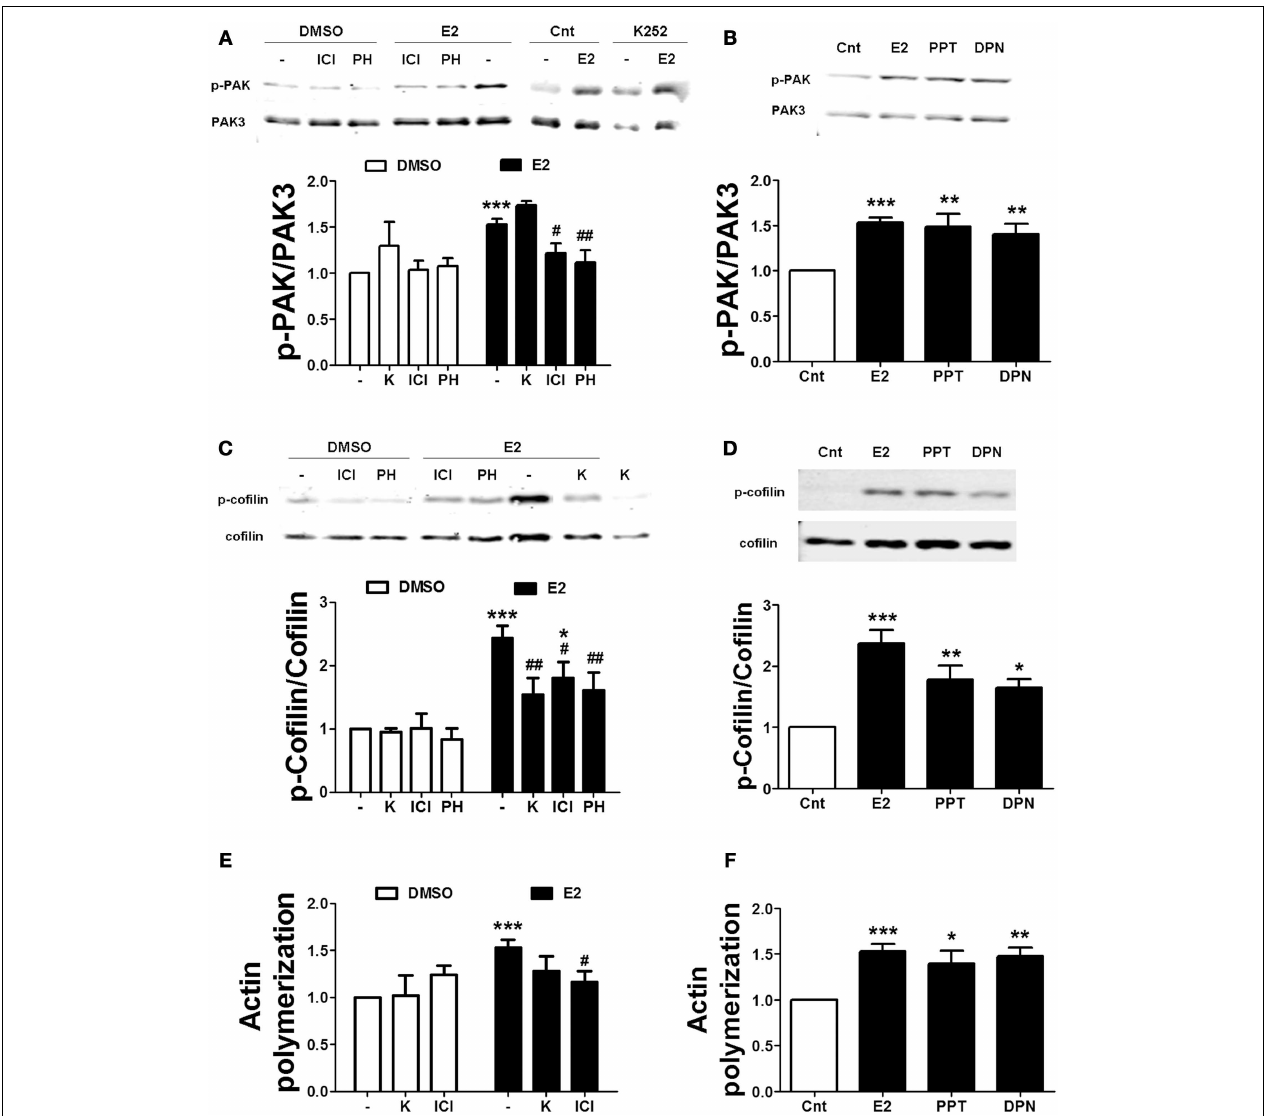
( N = 3–11). (E,F) Treatments were performed as described above (for E2 the incubation time was 60min) and then slices were fixed, homogenized and labeled with Phalloidin-TRITC (15–30nM). Data are presented as fluorescence values (fold of control) and are means ± SEM of three to seven independent experiments; * p < 0.05, ** p < 0.01, *** p < 0.001, as compared to control (DMSO); # p < 0.05 ## p < 0.01, as compared to E2 alone (one- or two-way